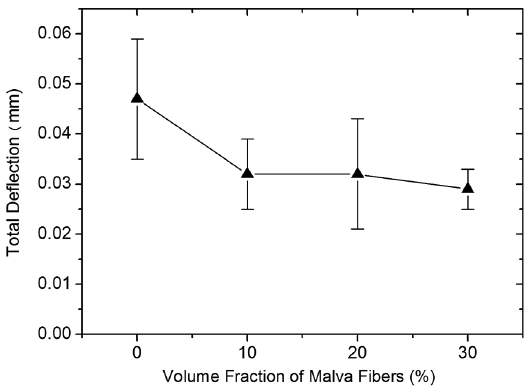
Figure 5. Variation of the total deflection with the volume fraction of malva fibers in epoxy composites.